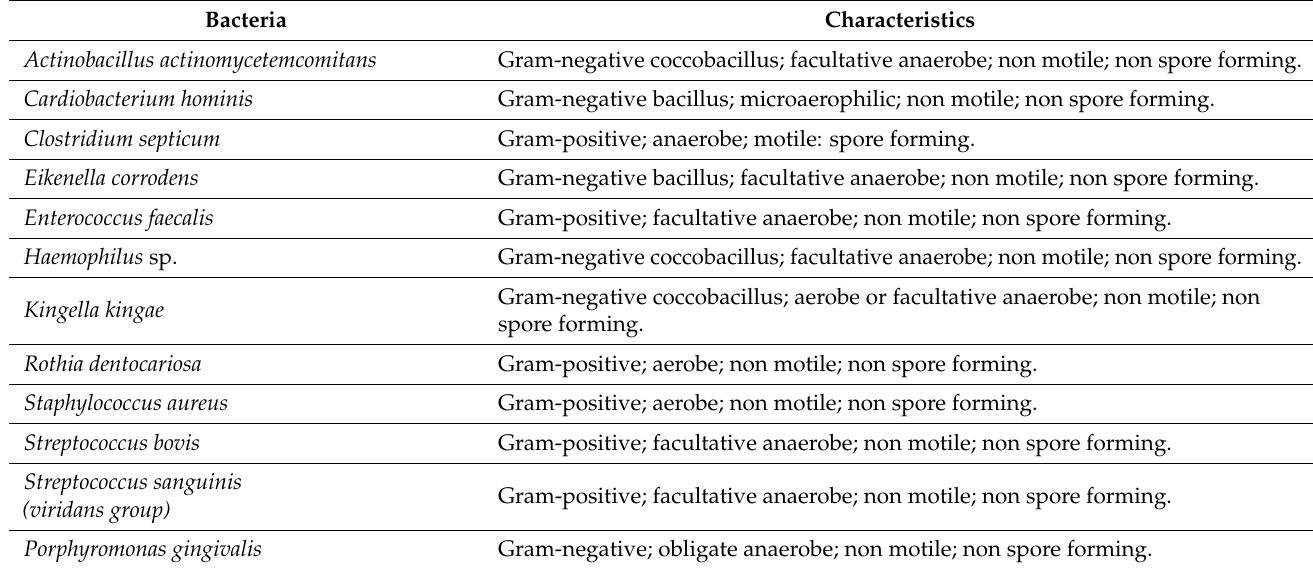
Table 2. List of the leading bacterial pathogens isolated from infective endocarditis patients. Bacteria